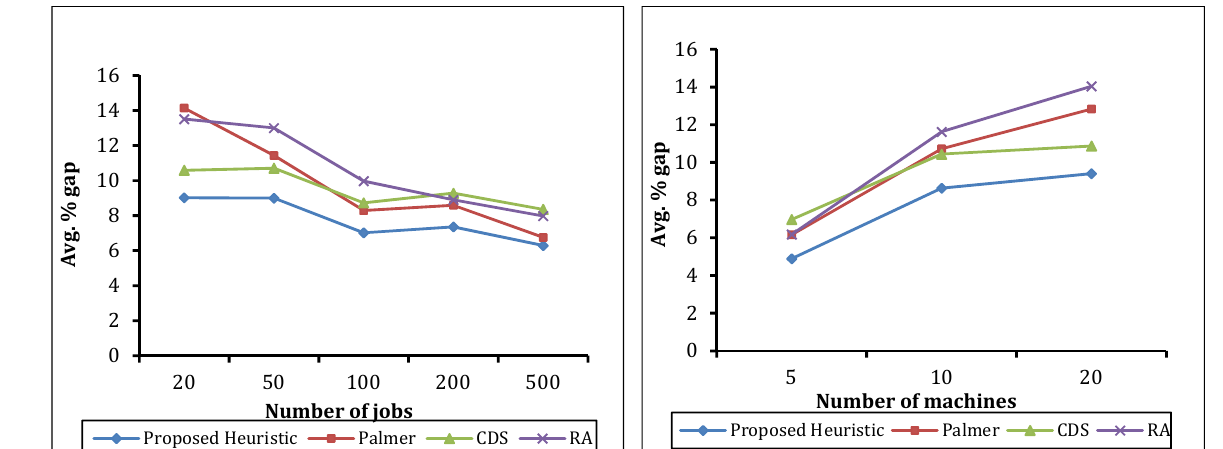
Fig. 2 Heuristics avg. % gap versus number of jobs Fig. 3 Heuristics avg. % gap versus number of